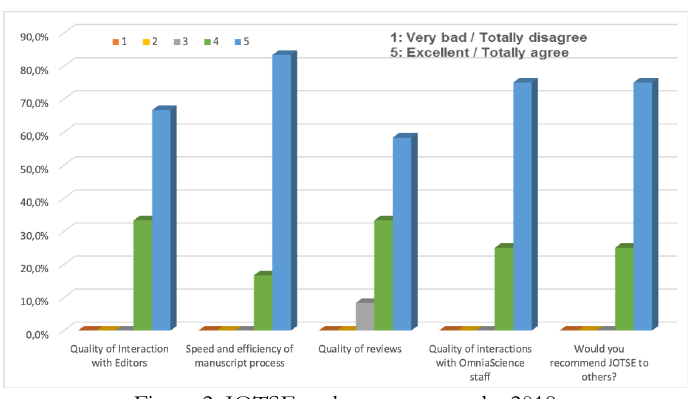
(only in the third position) appeared Spain with 13.29%. This is a clear evidence that the degree of internationalisation of JOTSE Journal is